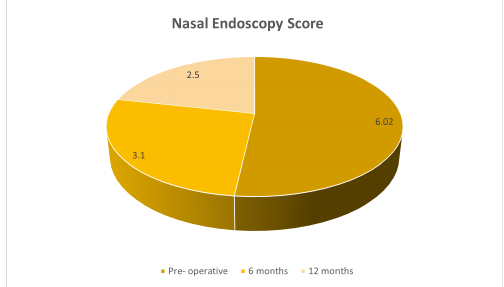
Figure 2. Nasal Endoscopy